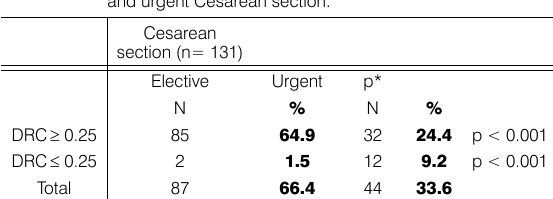
Table 3. Comparison of dehiscence risk coefficient after elective and urgent Cesarean